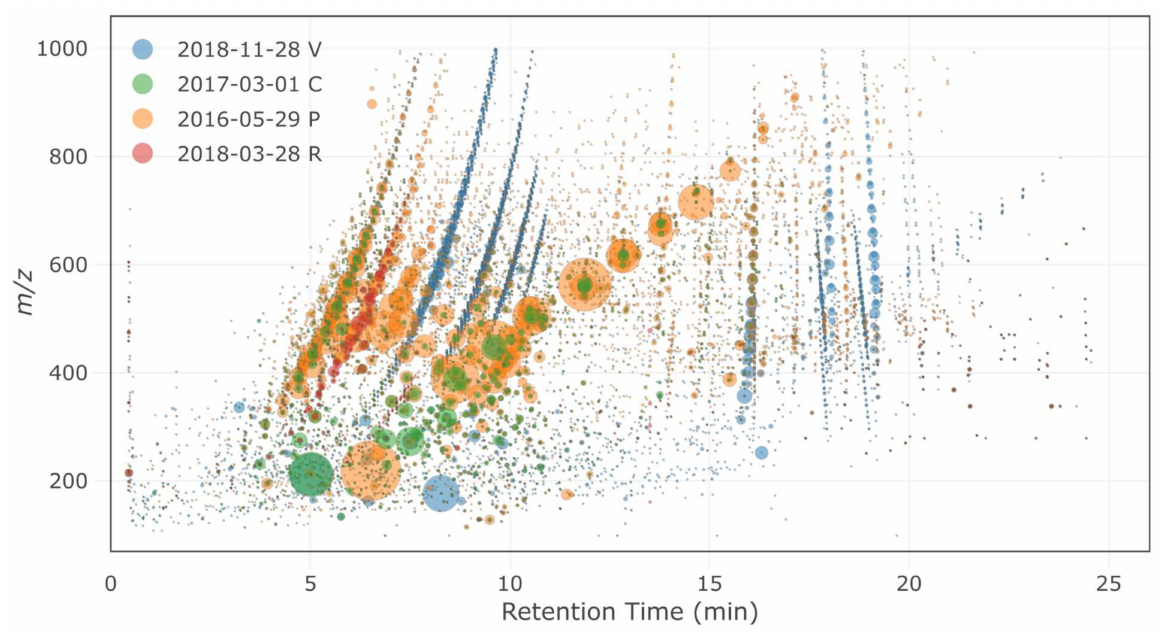
Figure 5. HRMS fingerprints of the selected samples (P = Paris, C = Compans, R = Rosny-sous-Bois